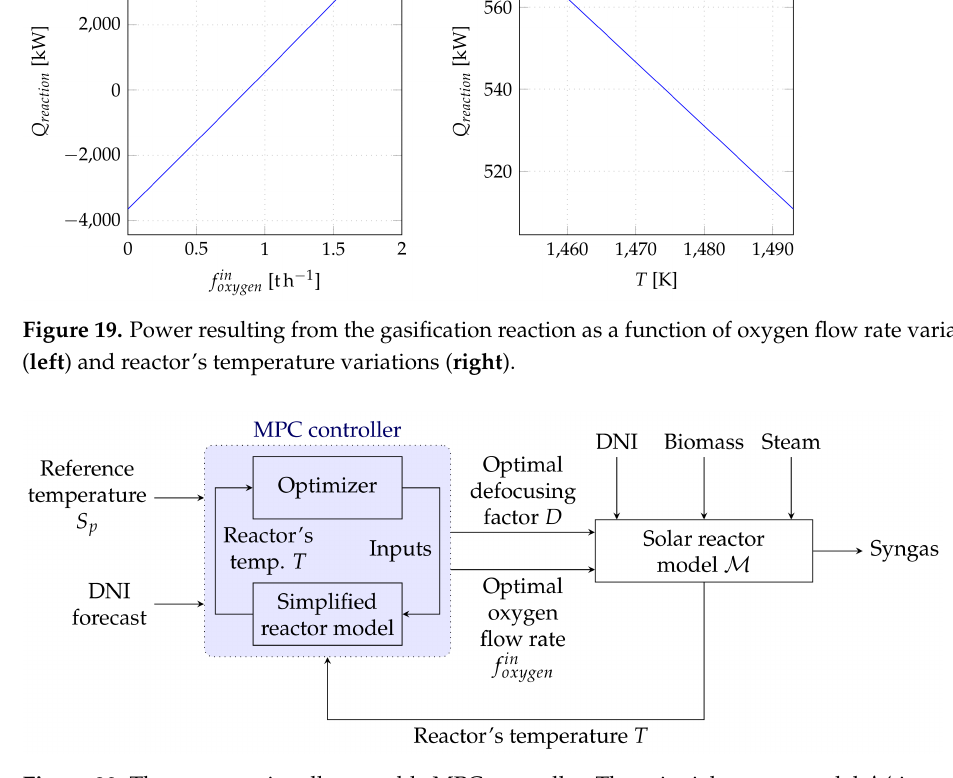
Figure 20. The computationally tractable MPC controller. The orignial reactor model M is replaced with the simplified model to solve the optimization problem. The original model M is still used to perform the